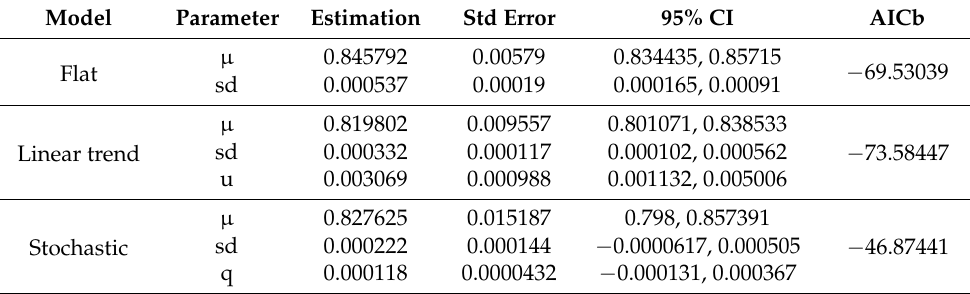
Table 3. Comparison of the three models for the hunting sustainability